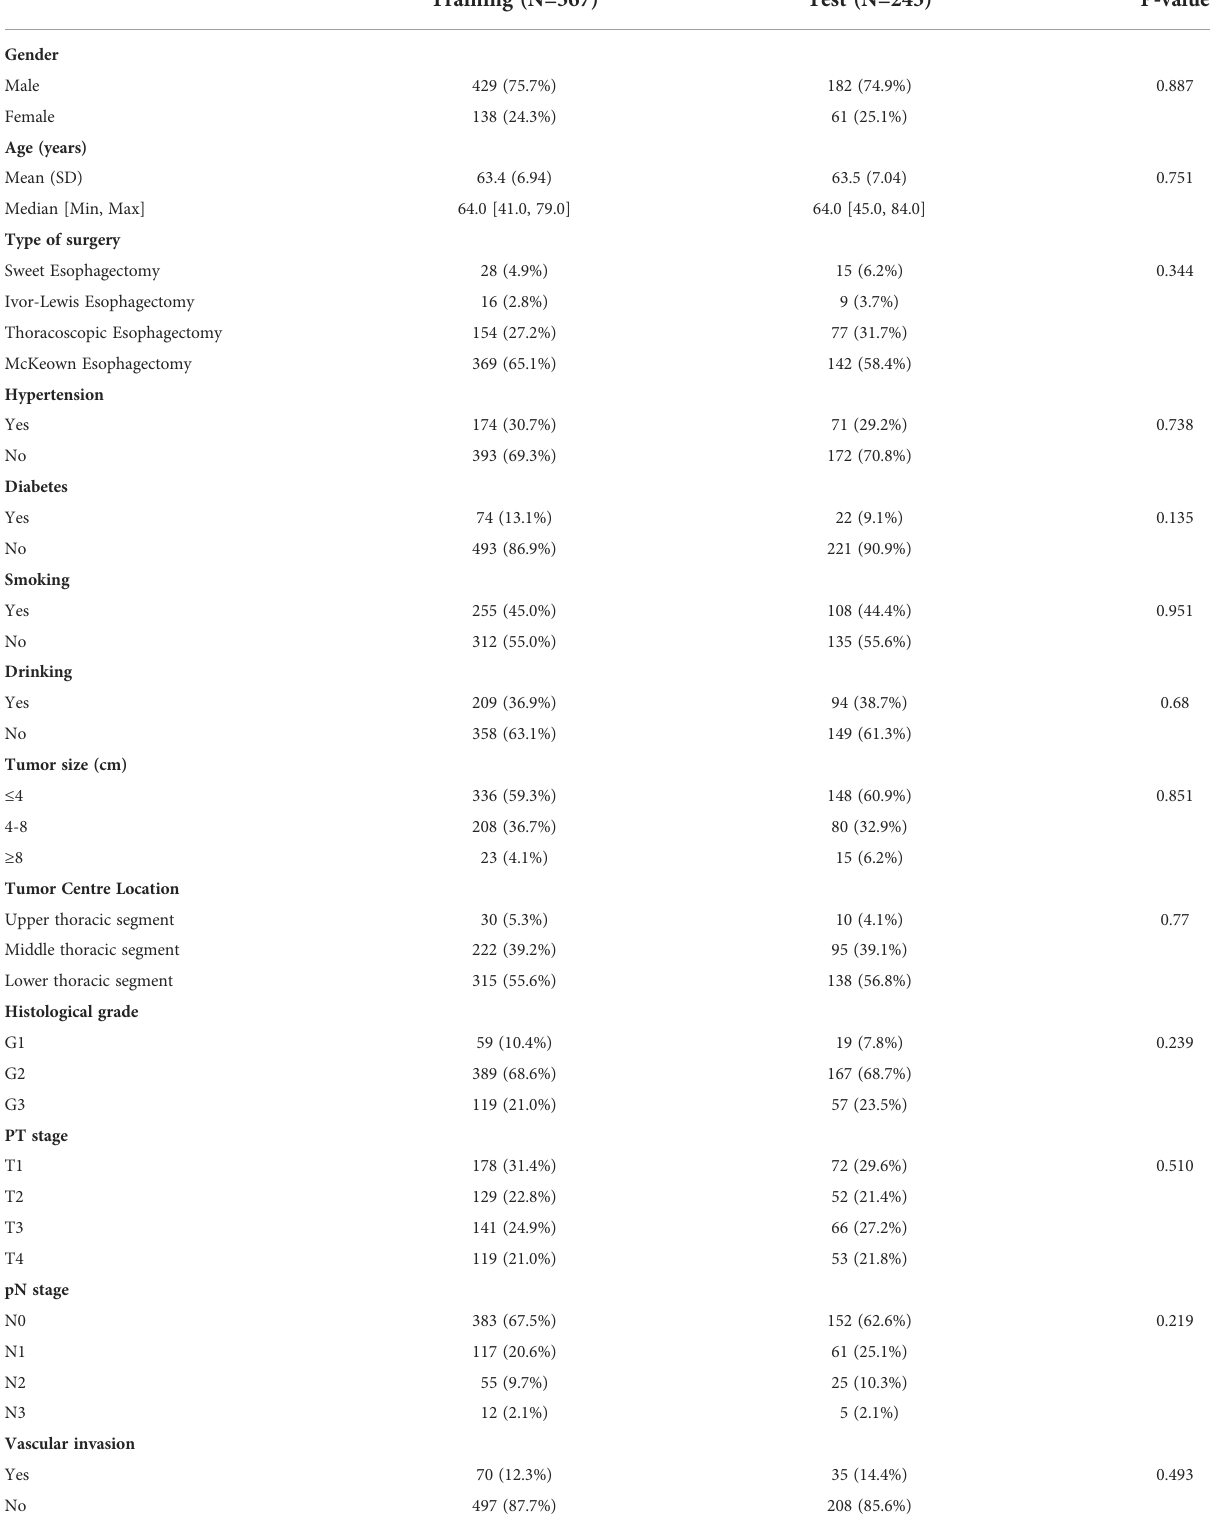
TABLE 1 Comparison of clinicopathological characteristics between the training and test